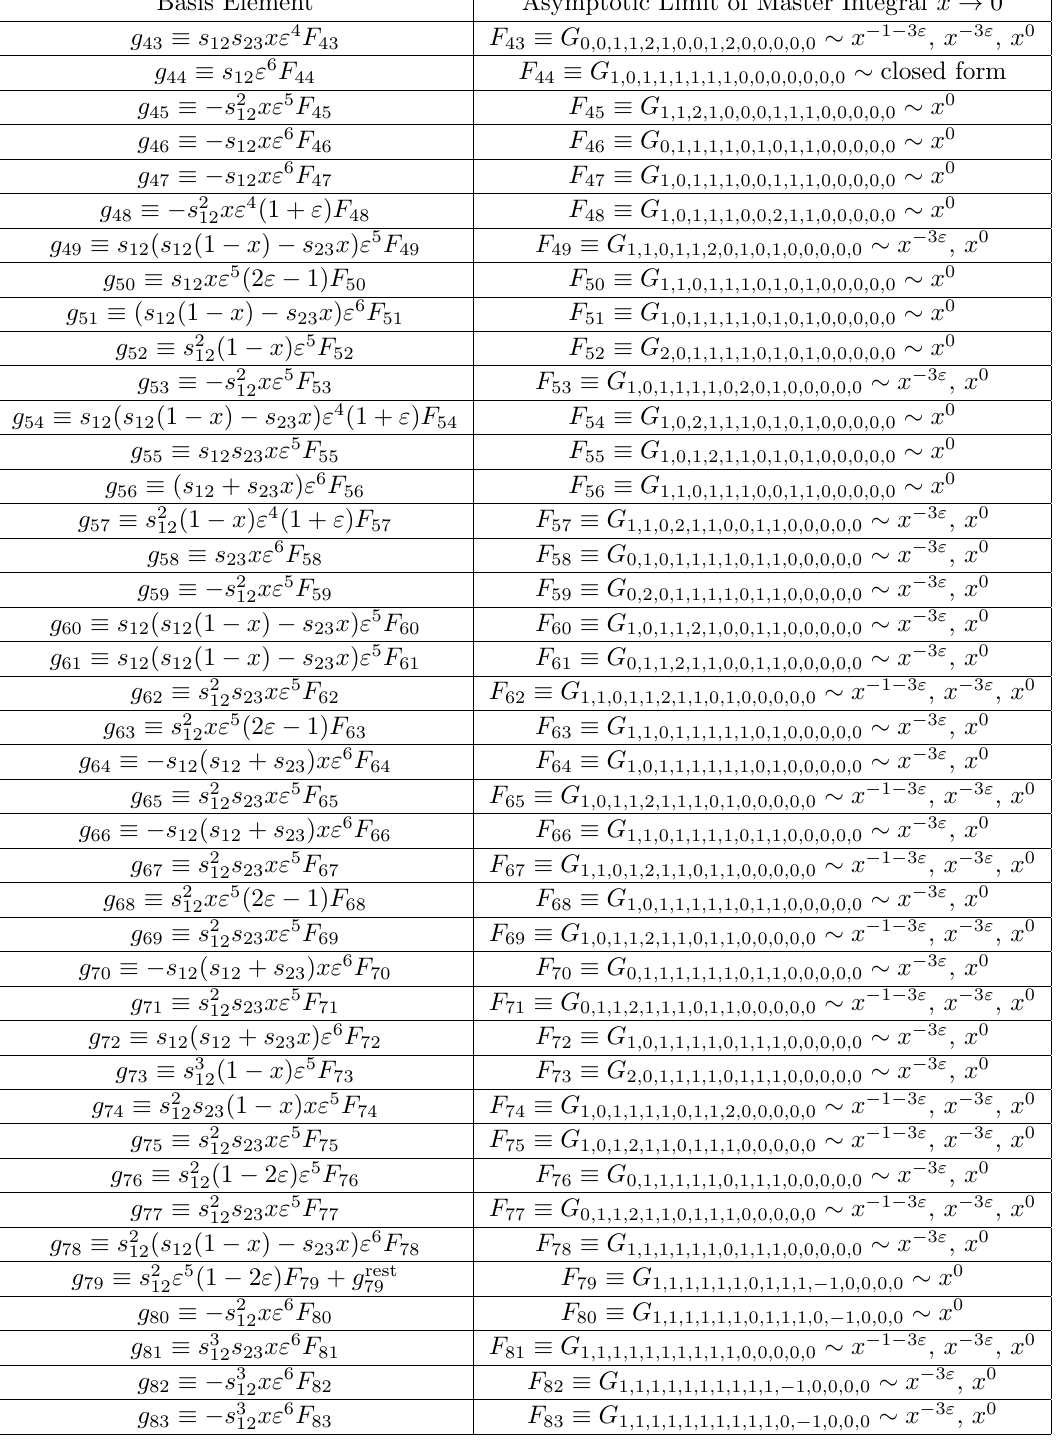
Table 2 . The rest 41 U.T. basis elements in the SDE notation. For space convenience we used the s 12 ( x notation g rest 1) " 5 (2 F 23 +3 F 25 79 (cid:17) (cid:0)